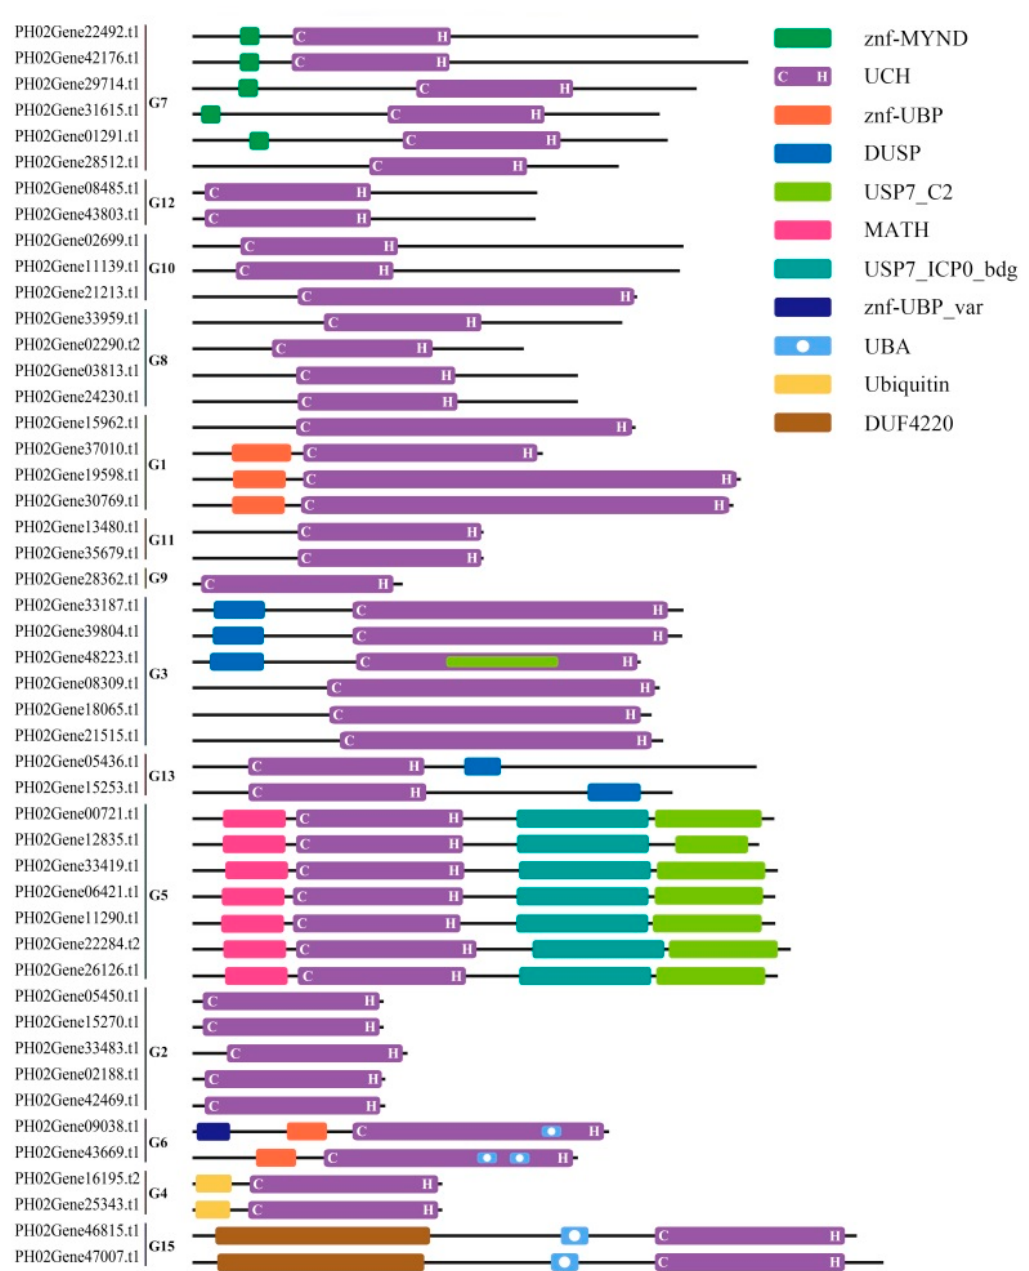
Figure 1. 48 PeUBP genes can be divided into 14 groups (G1–G13, and G15) based on the predicted amino acid sequence identities and domain structures. The domains are indicated by different colored boxes.